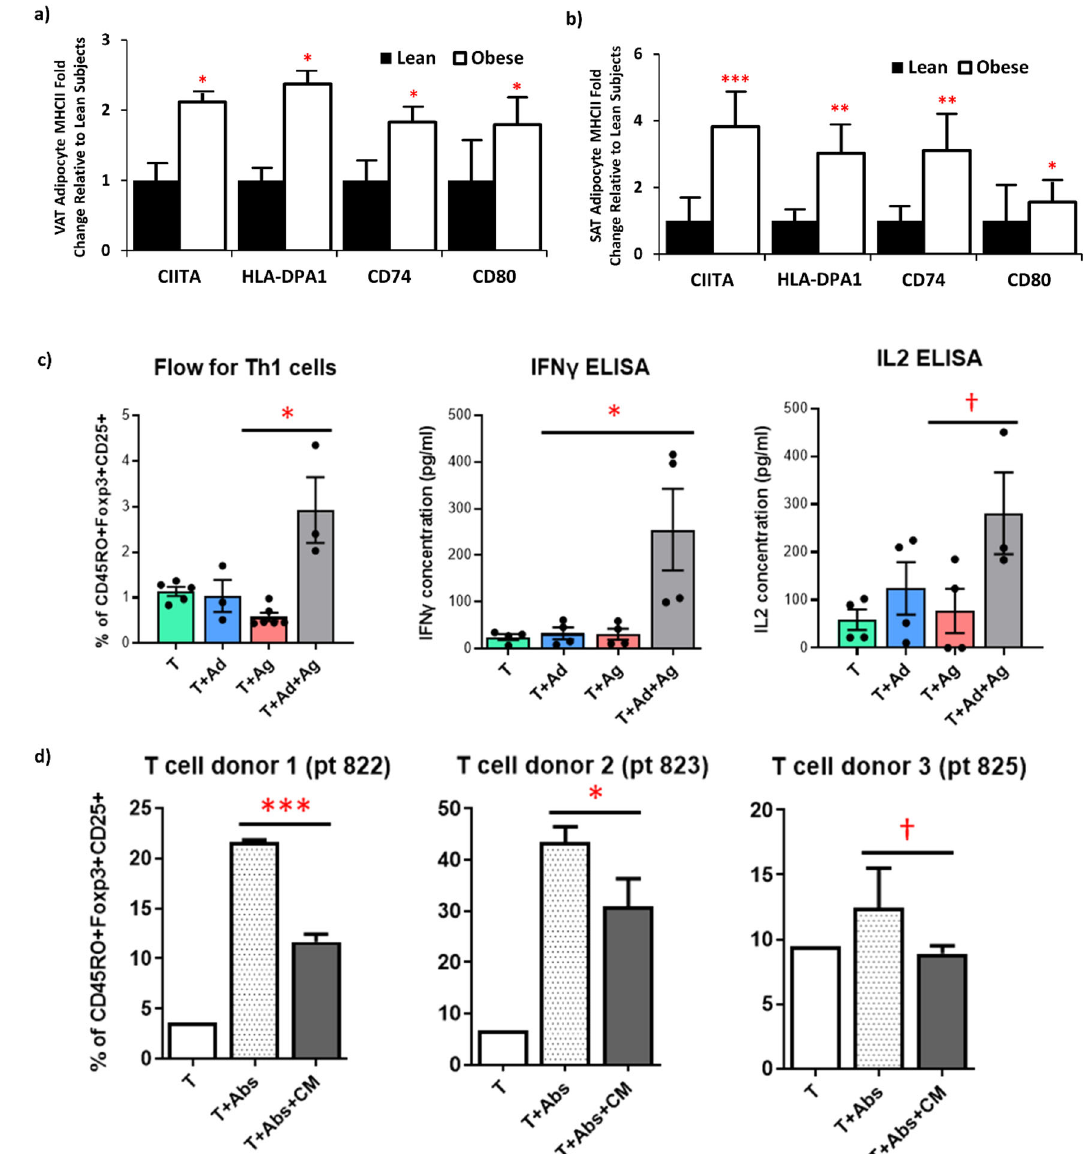
Fig. 2 | Human adipocyte antigen presentation contributes to adipose tissue in fl ammation. a Visceral (VAT) and b Subcutaneous (SAT) adipocyte gene expression in lean ( N =15) and obese ( N =83) subjects of MHCII-related genes by two-sided independent sample T -test. Source data are provided as a Source Data fi le.Meansforleansubjectgeneexpressionarepresentedasnormalized to1. c Co- culture of CD4+T cells from human obese subjects in the presence/absence of adipocytes and/or antigen (Copaxone (50 µ g/ml)) assessing the % Th1 cells of total CD4+cells by fl ow cytometry and IFN γ and IL-2 media levels by ELISA analyzed by